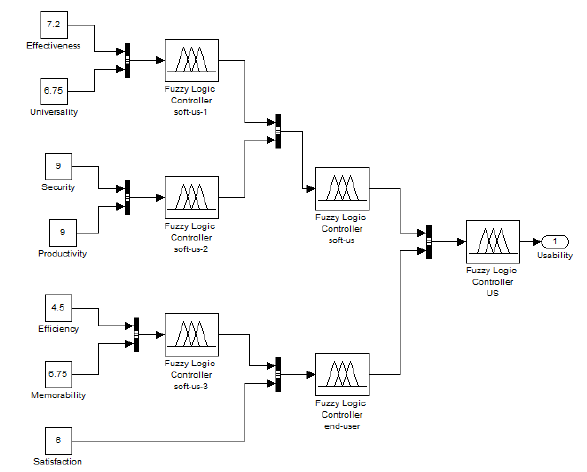
Figure 4: Simulation of the proposed hierarchical usability model